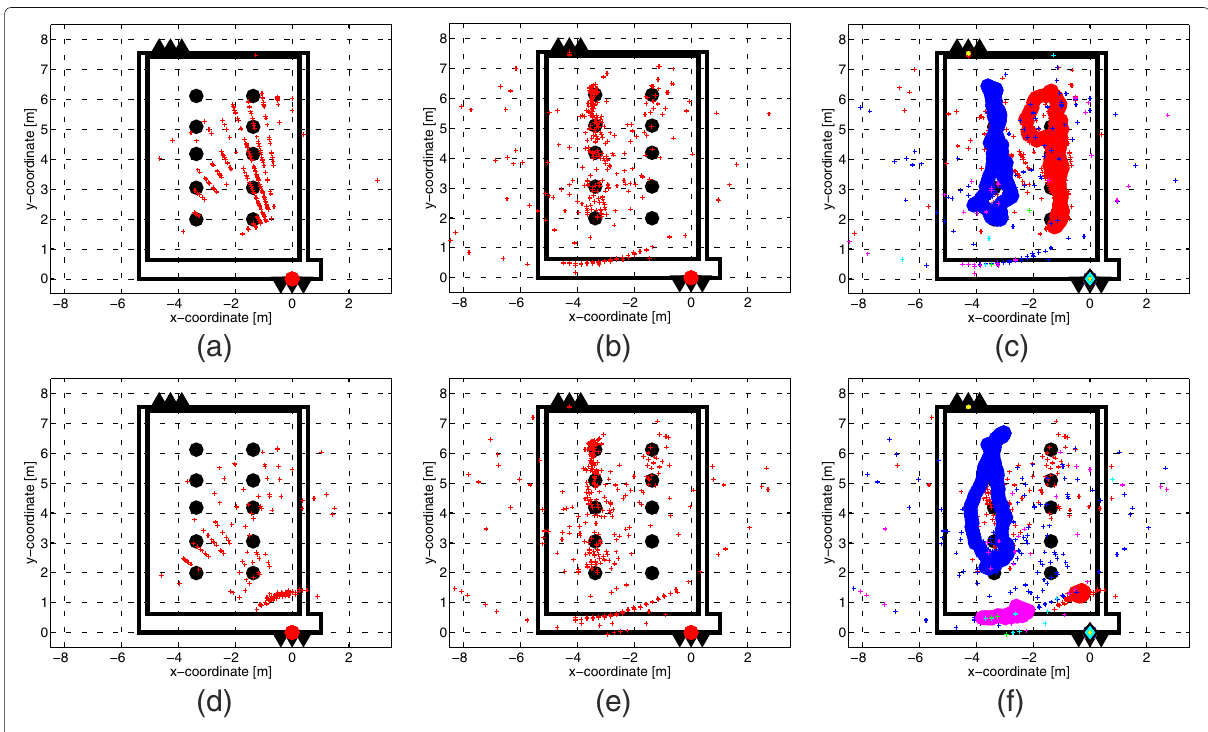
Fig. 11 Target localization and tracking by the UWB sensor network. Scenario 1: a input data of MTT from sensor S1, b input data of MTT from the sensor S2, c the fusion center output - the final target track estimate. Scenario 2: d input data of MTT from sensor S1, e input data of MTT from sensor S2, f the fusion center output - the final target track estimate